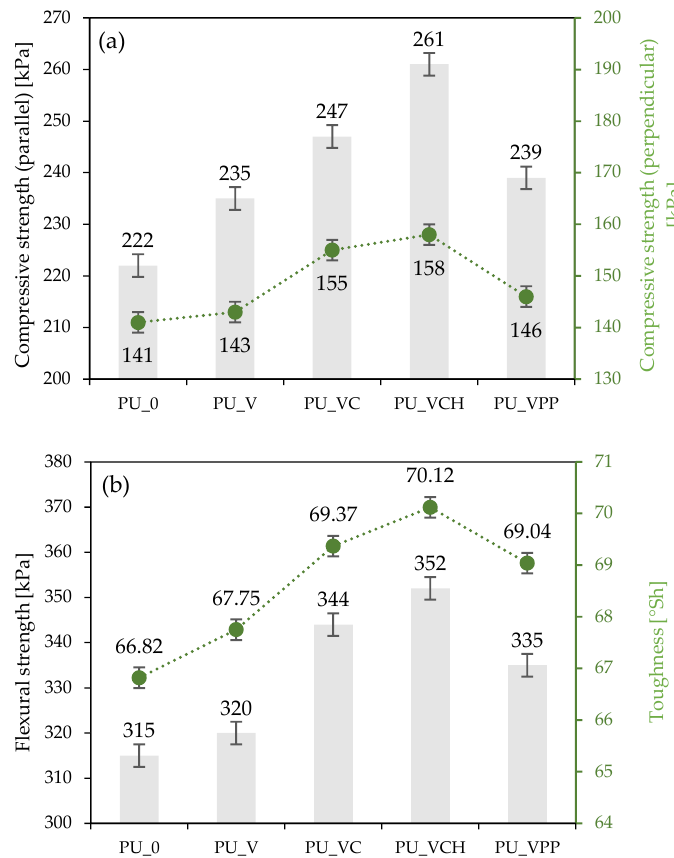
Figure 6. Effect of vermiculite fillers on parallel and perpendicular compressive strength ( a ) and flexural strength and toughness ( b ).